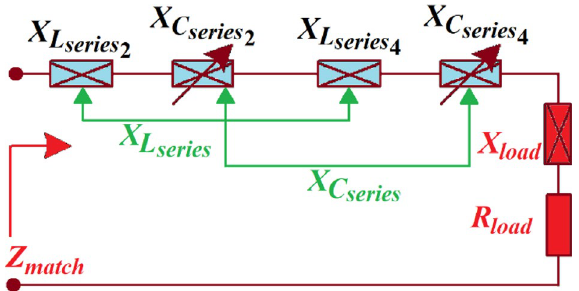
Figure 5. Adjustable LC -network to provide the required inductive and capacitive load